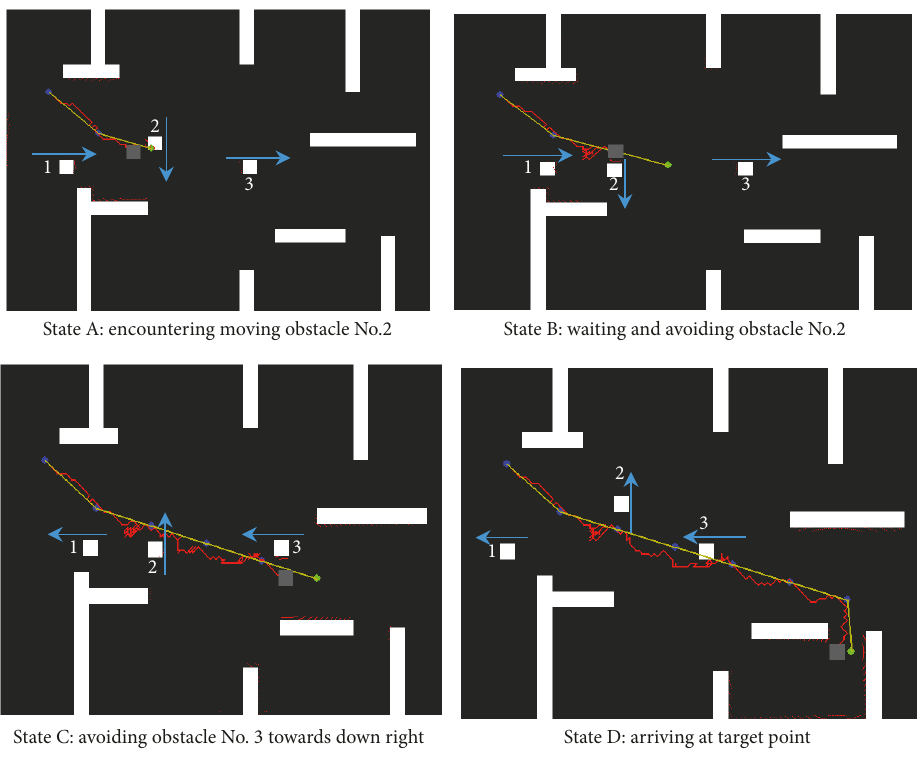
Figure 6: Local path planning in a test